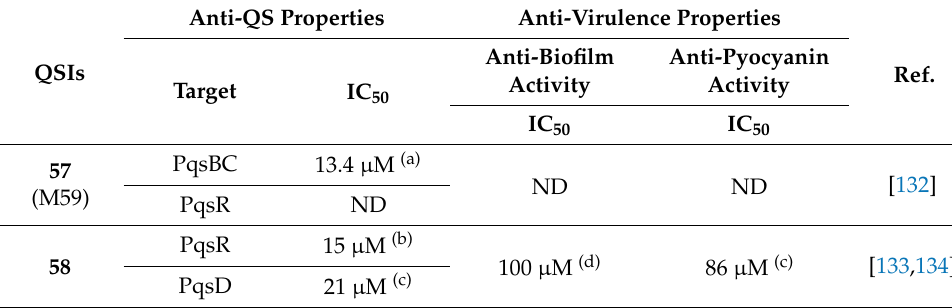
Table 8. Anti-QS and anti-virulence of multi-target QSIs.